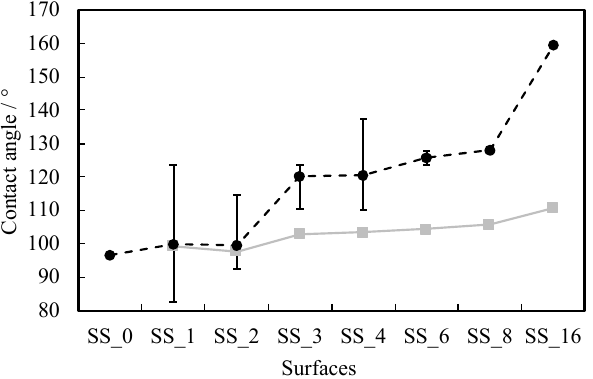
Figure 10. Contact angles of the fluid droplet formed over model surfaces of various sinusoidal wavelengths (Table 1). The black dots are data from the simulations while the gray square shows the prediction of the Wenzel model (Equation (6)) using the modeled contact angle on the flat surface SS_0 as the equilibrium contact angle θ 0 . Lines connecting the data points are used to guide to the eye.